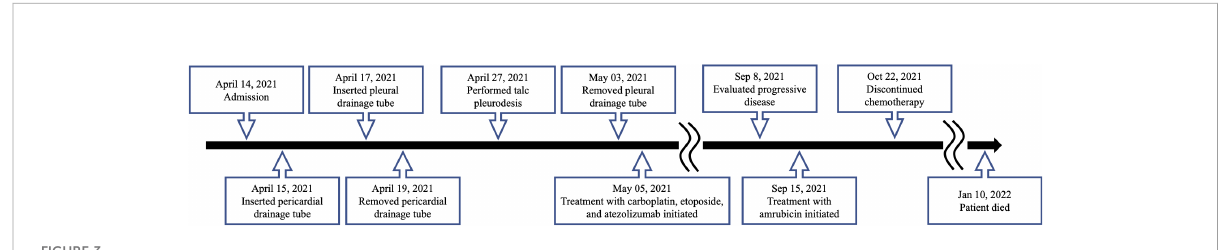
FIGURE 3 Timeline of the main interventions from the initial visit to the treatment